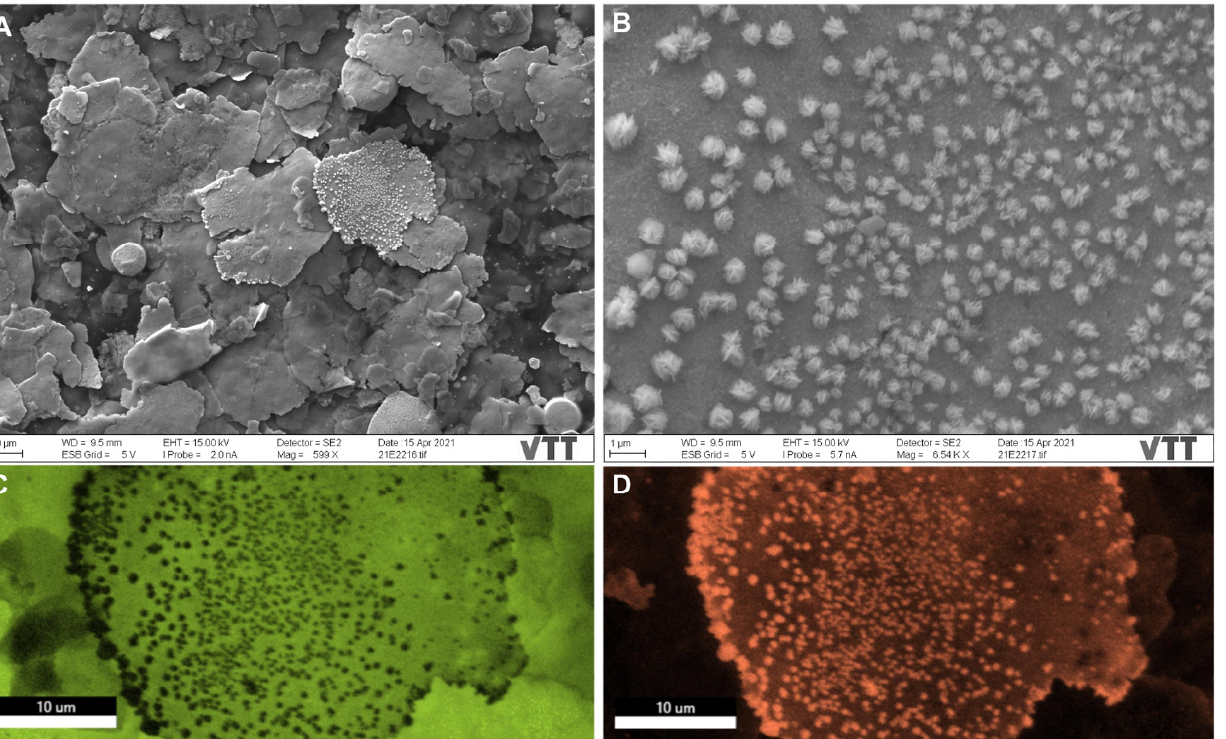
Figure 2. SEM images and energy-dispersive X-ray spectroscopy (EDX) mapping of sample A. ( A ) SEM image of morphological irregular copper flakes. ( B ) SEM image of star-shaped Ag nanoparti- cles (NPs) decorating the copper flakes. ( C ) Mapped image of morphological irregular copper flakes denoted in green. ( D ) Mapped image of star-shaped Ag NPs decorating the copper flakes denoted in orange.